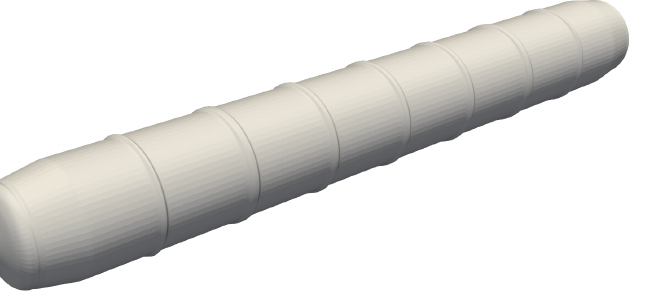
Figure 3. Geometry 2: Cylindrical hull with ring protrusions, representing the geometry of the pressure hull with rings.